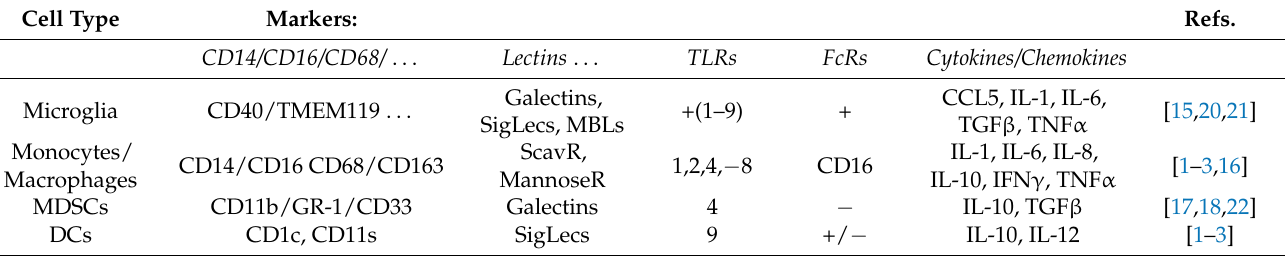
MDSCs: Myeloid-derived suppressor cells; DCs: Dendritic